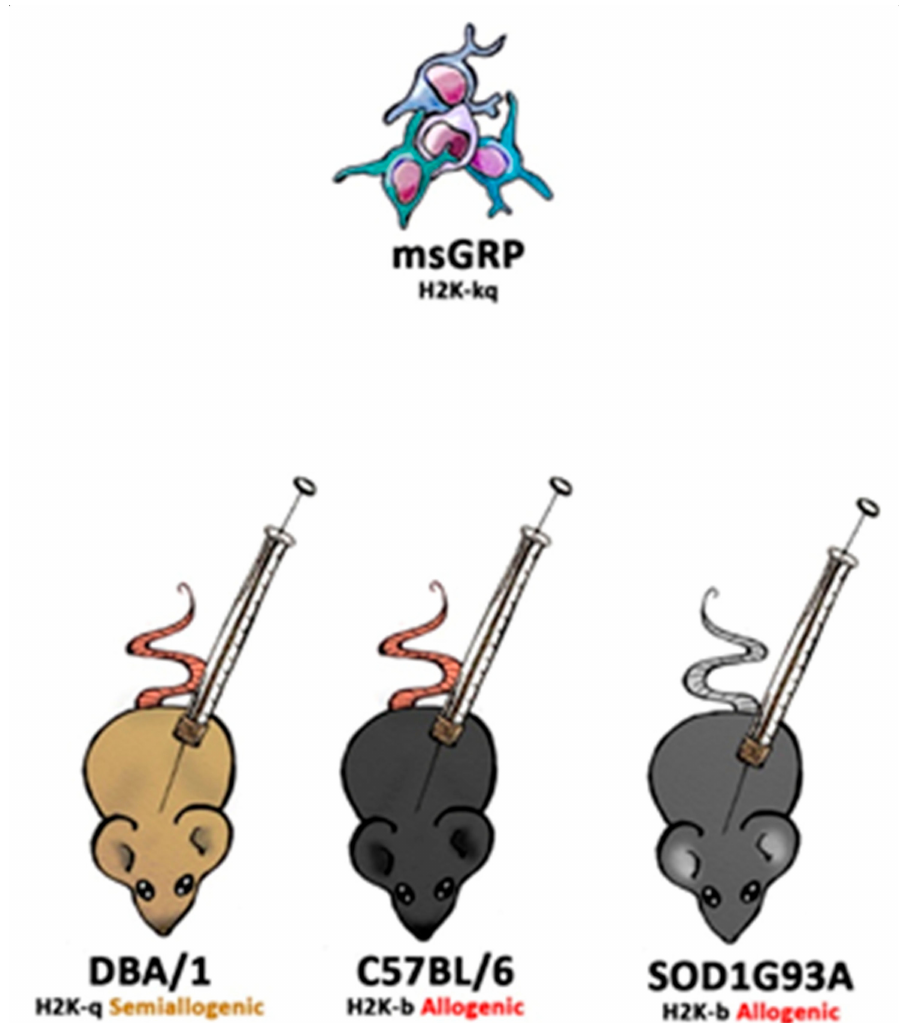
Figure 1. The scheme of in vivo murine glial restricted progenitors (GRPs) grafting